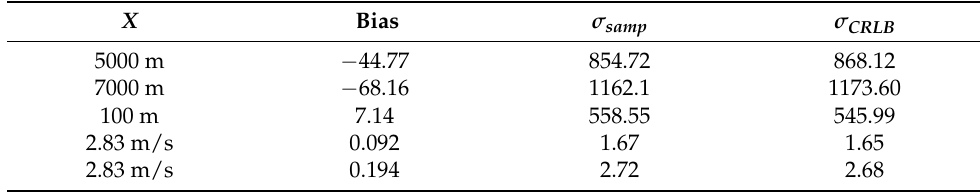
Table 3. Performance of the estimator of the plain state vector.